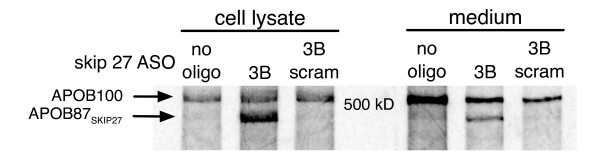
Transfection of APOB skip 27 ASOs causes expression of a short isoform of APOB, APOB87SKIP27. HepG2 cells were transfected with the indicated ASOs at 250 nM, then pulse-labelled with Trans-35S-Label for 1 hour in the presence of oleic acid-BSA, which stimulates APOB100 expression [62]. Cell lysates or cell culture media were immunoprecipitated with a polyclonal antibody for APOB. The immunoprecipitates were subjected to SDS-PAGE (4% Tris-glycine), followed by autoradiography. The gel shown is representative of three experiments. A short isoform of APOB, APOB87SKIP27, is seen with the skip 27-3B ASO. This short isoform is not seen with the 3B scram ASO, nor with the no-oligo control. This matches the presence and absence of skip 27 mRNA seen with these ASOs.